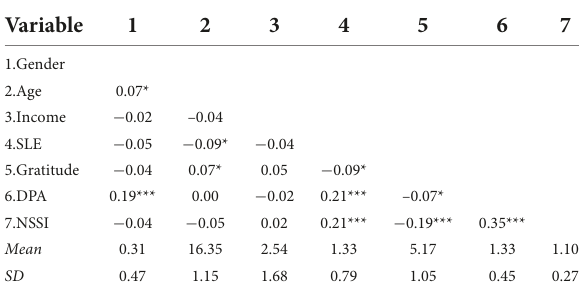
TABLE 1 Descriptive statistics and correlations for all